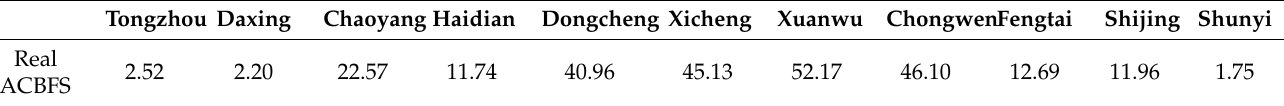
Table 5. The values of real ACBFS in each county of Beijing.